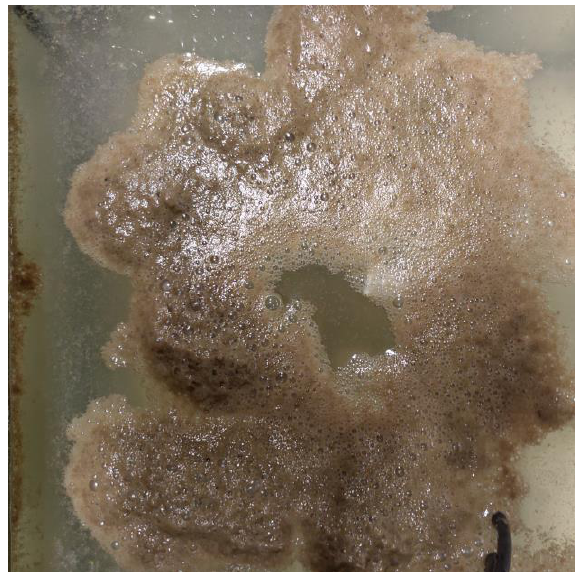
Fig. 6. The photograph was taken after ultrasonic